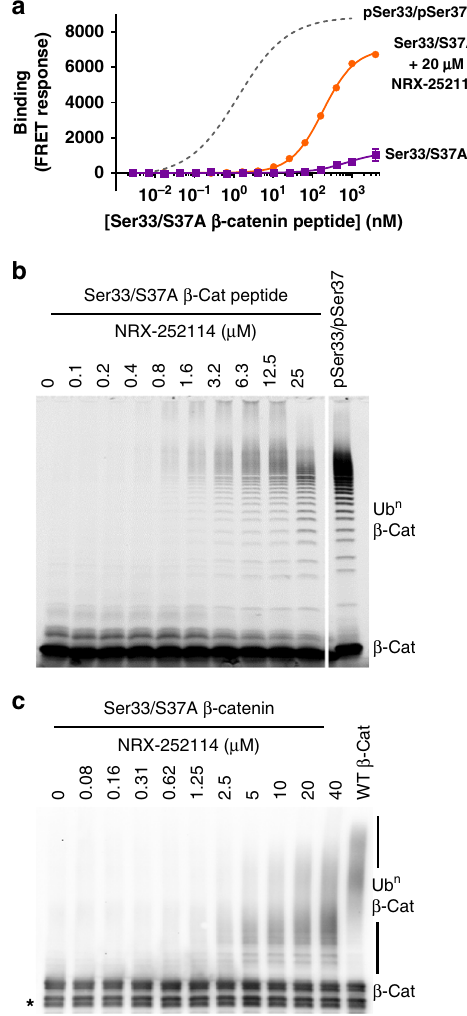
Fig. 4 Enhancers potentiate binding and ubiquitylation of the unphosphorylated β -catenin degron. a Binding of Ser33/S37A β -catenin peptide for β -TrCP measured in the TR-FRET assay in absence or presence of 20 μ M NRX- 252114. For reference, the binding curve for pSer33/pSer37 β -catenin peptide in the same TR-FRET assay is represented in dotted gray line. b Ubiquitylation of Ser33/S37A β -catenin peptide (residues 17 – 60) by SCF β -TrCP in the presence of NRX-252114 under conditions similar to Fig. 3d. c 400 nM puri fi ed full-length S37A mutant β -catenin protein was ubiquitylated in the presence of 125 nM Ube1, ATP, 1.75 μ M Cdc34, and 400 nM SCF β -TrCP with the increasing concentration of NRX-252114. Reactions were resolved by SDS-PAGE and analyzed by immuno-blotting with a β -catenin C-terminal antibody. For reference, ubiquitylation of WT β - catenin protein is also shown (* refers to degradation